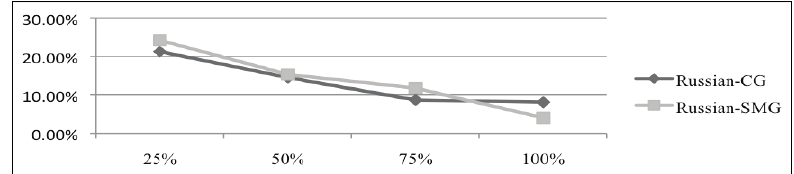
Figure 5: Greek use of the participants and non-target test